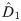
Spectral distances contrast D^1—For the three matrices: Adjacency, combinatorial Laplacian, and normalized Laplacian (from left to right)—Between the stochastic blockmodel and the uncorrelated random graph model (null model).